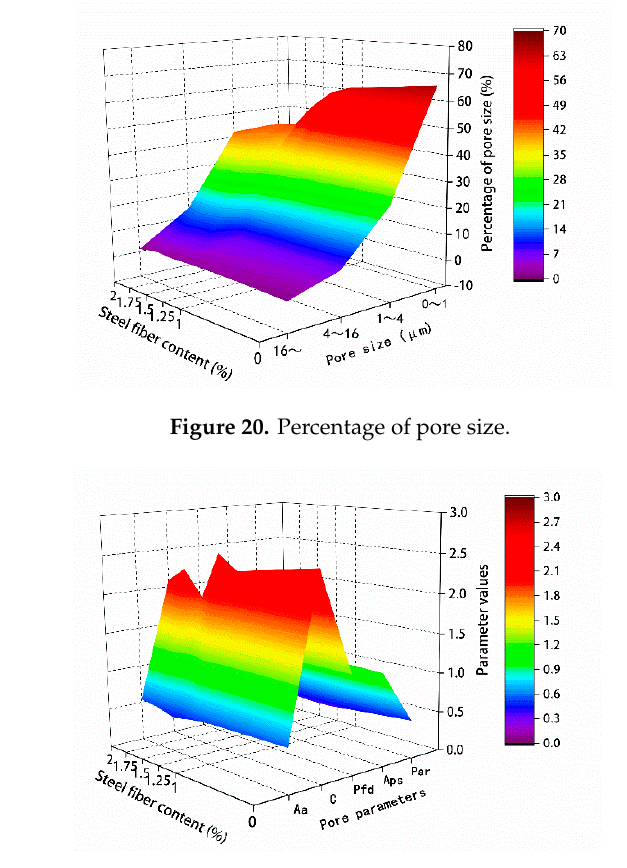
Figure 21. Pore microparameter.